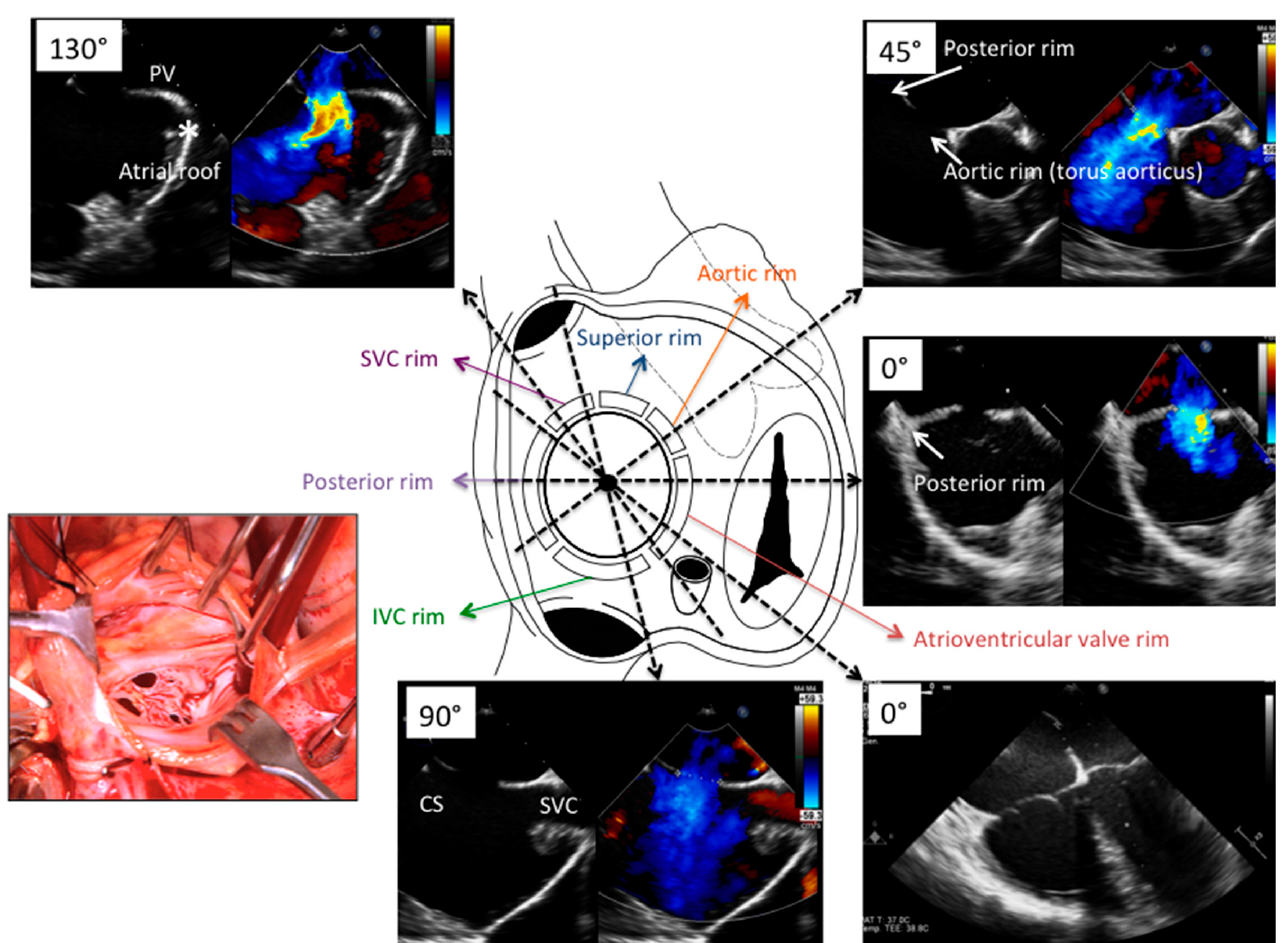
Figure 3. Atrial septal defect and surrounding borders. Right atrial view of atrial septum is shown along with relationship between atrial septal defect and surrounding borders. Appropriate and border-specific TEE views are presented. Anatomical view is provided for comparison (left insert). TEE = Trans-Esophageal Echocardiography.